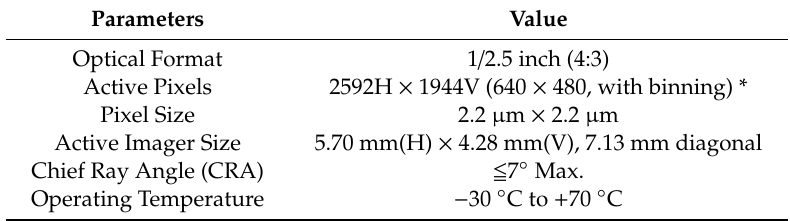
Table 1. Major parameters of ON Semiconductor ® Aptina ™ MT9P031